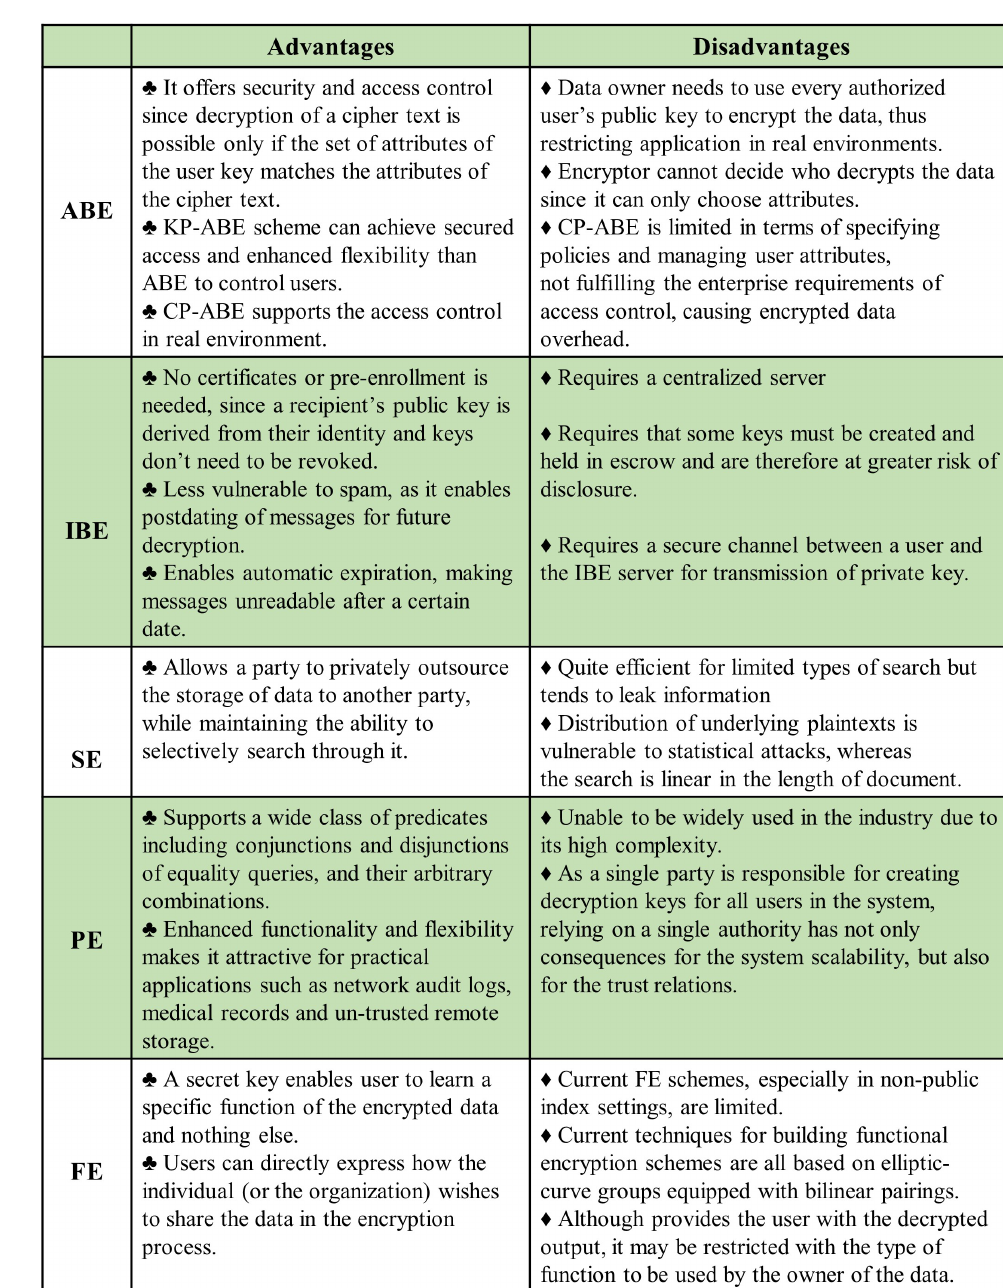
Figure 6. A brief summary of the advantages and disadvantages of cryptographic primitives consid- ered in this